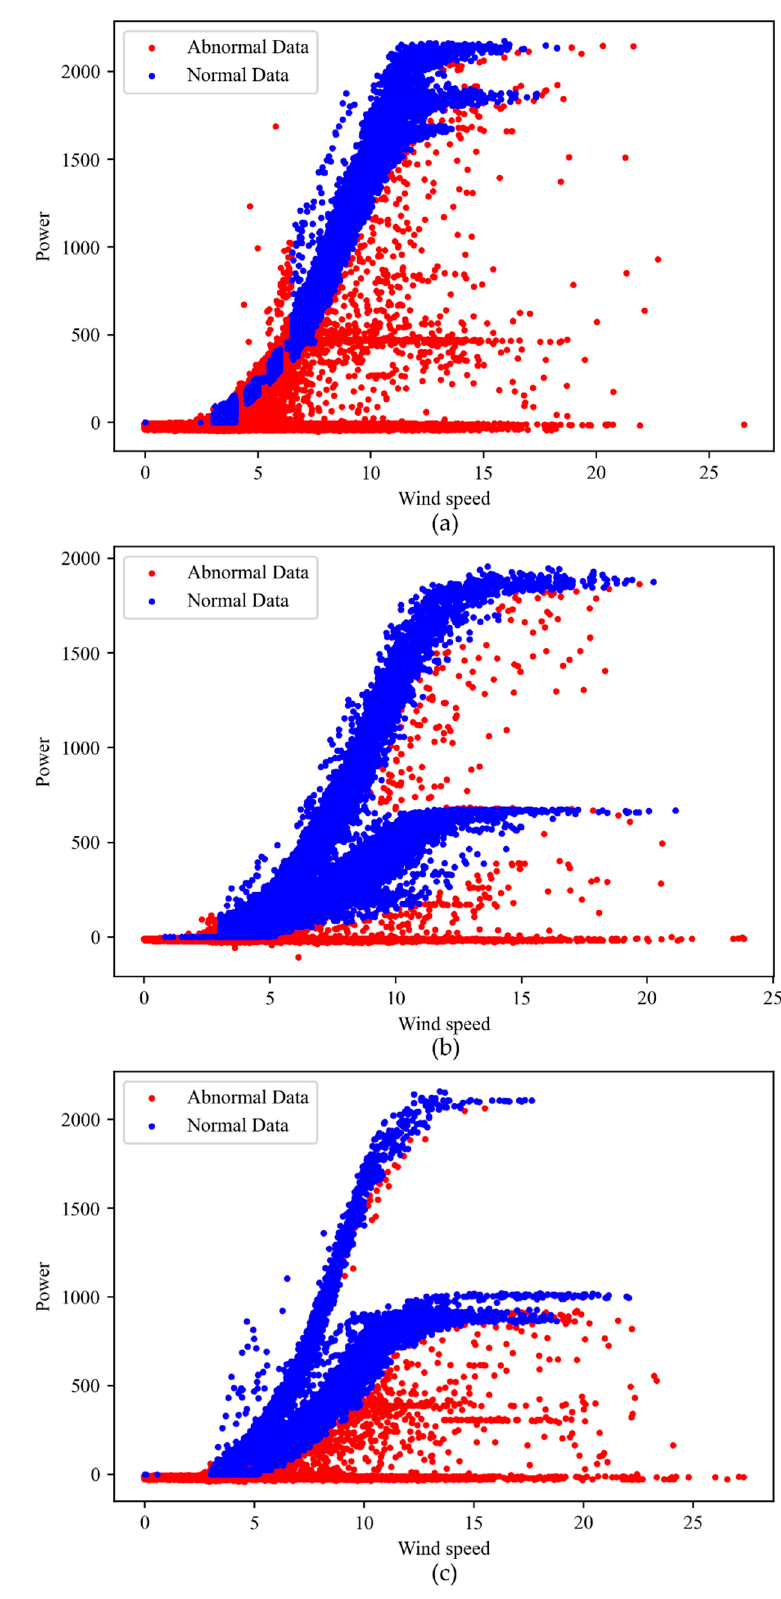
Figure 13. Abnormal data cleaning results using the DBSCAN algorithm: ( a ) #1 wind turbine; ( b ) #2 wind turbine; ( c ) #3 wind turbine.